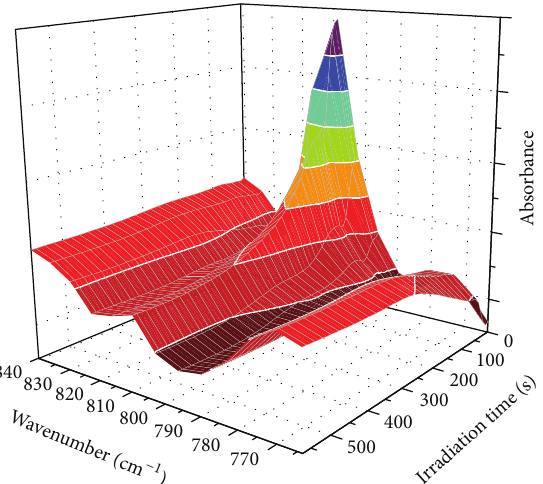
Figure 6: 3D profile of UVCF formulations at bands of 810 cm −1 was recorded under different UV irradiation time by real time FT-IR.